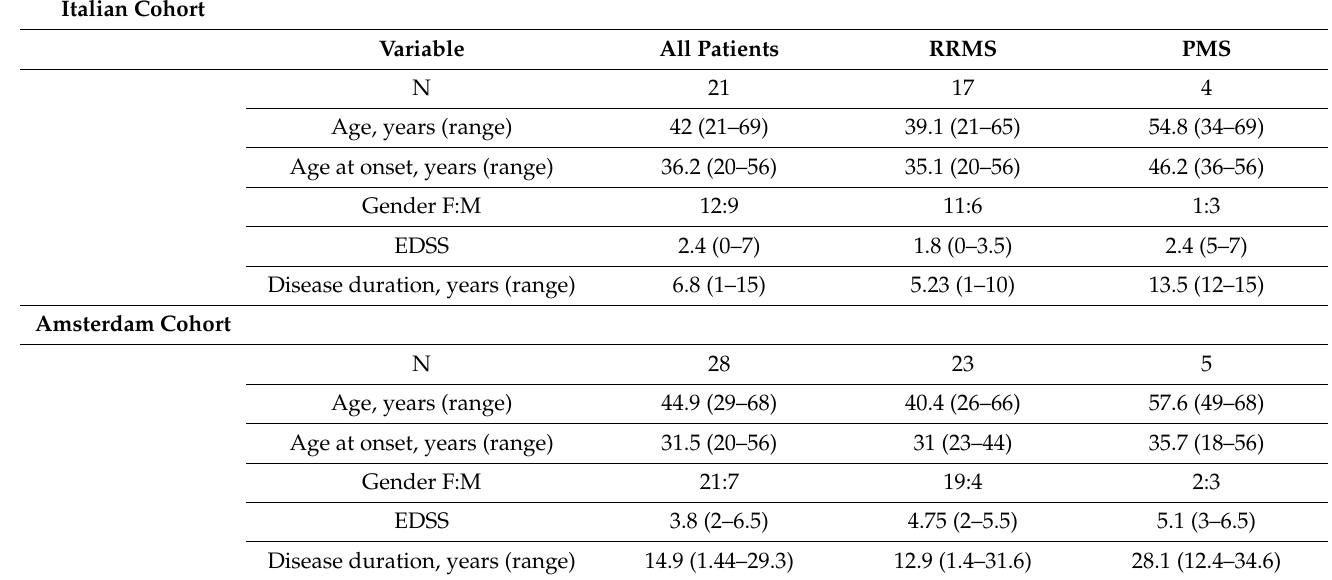
Table 1. Demographic and clinical features of the two cohorts of patients